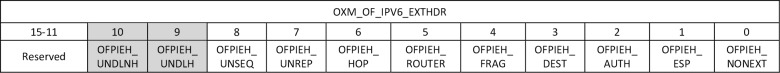
OXM_OF_IPV6_EXTHDR match field with the new flags.